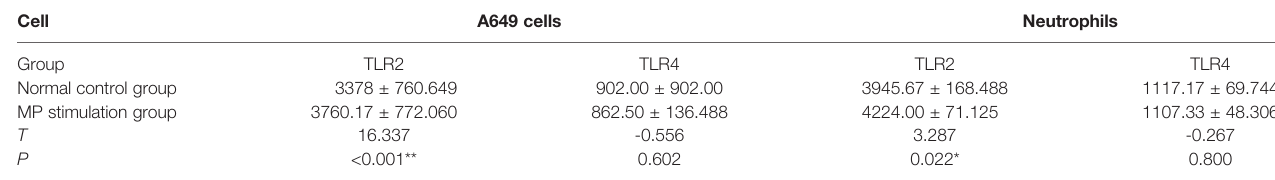
TABLE 2 | Difference in mean fl uorescence intensity between TLR2 and TLR4 in normal control group and MP stimulation group in neutrophils and A549 cells. Cell